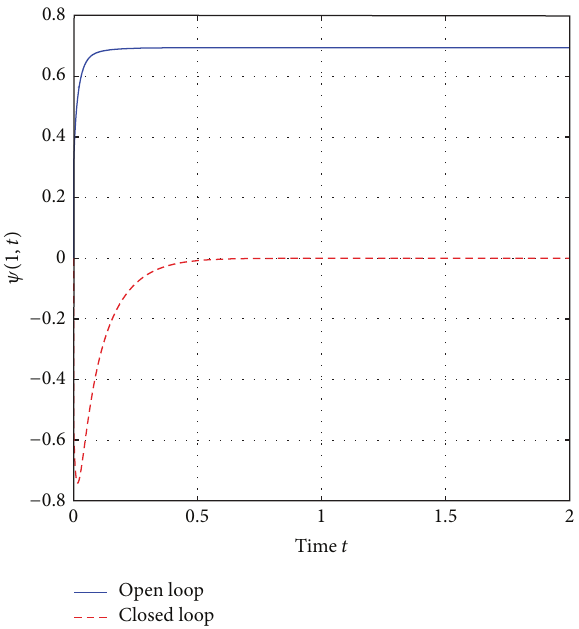
Figure 4: Boundary control input for 𝜓(1,𝑡)